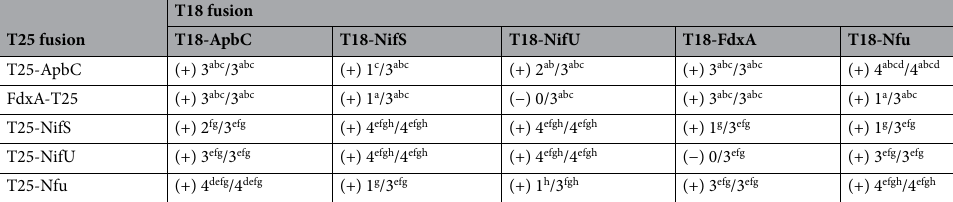
Table 3. Summary of interactions between core components of the H. pylori NIF system. ( +): interactions have been detected, at least with one method; (−): no interaction could be detected. Fraction numbers indicate the numbers of methods showing interactions over the total number of methods used. Superscript letters refer to the detection method: (a) MC-Mal (this study); (b) LB-X-Gal (this study); (c) M63-Mal (this study); (d) cross-linking (this study); (e) MC-Mal 29 ; (f) LB-X-Gal 29 ; (g) M63-Mal 29 ;(h) SEC 29 .